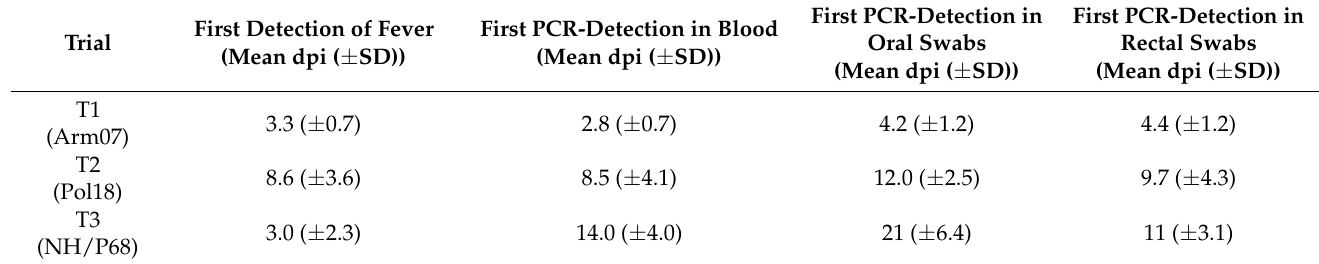
Table 3. Mean latent and incubation periods.